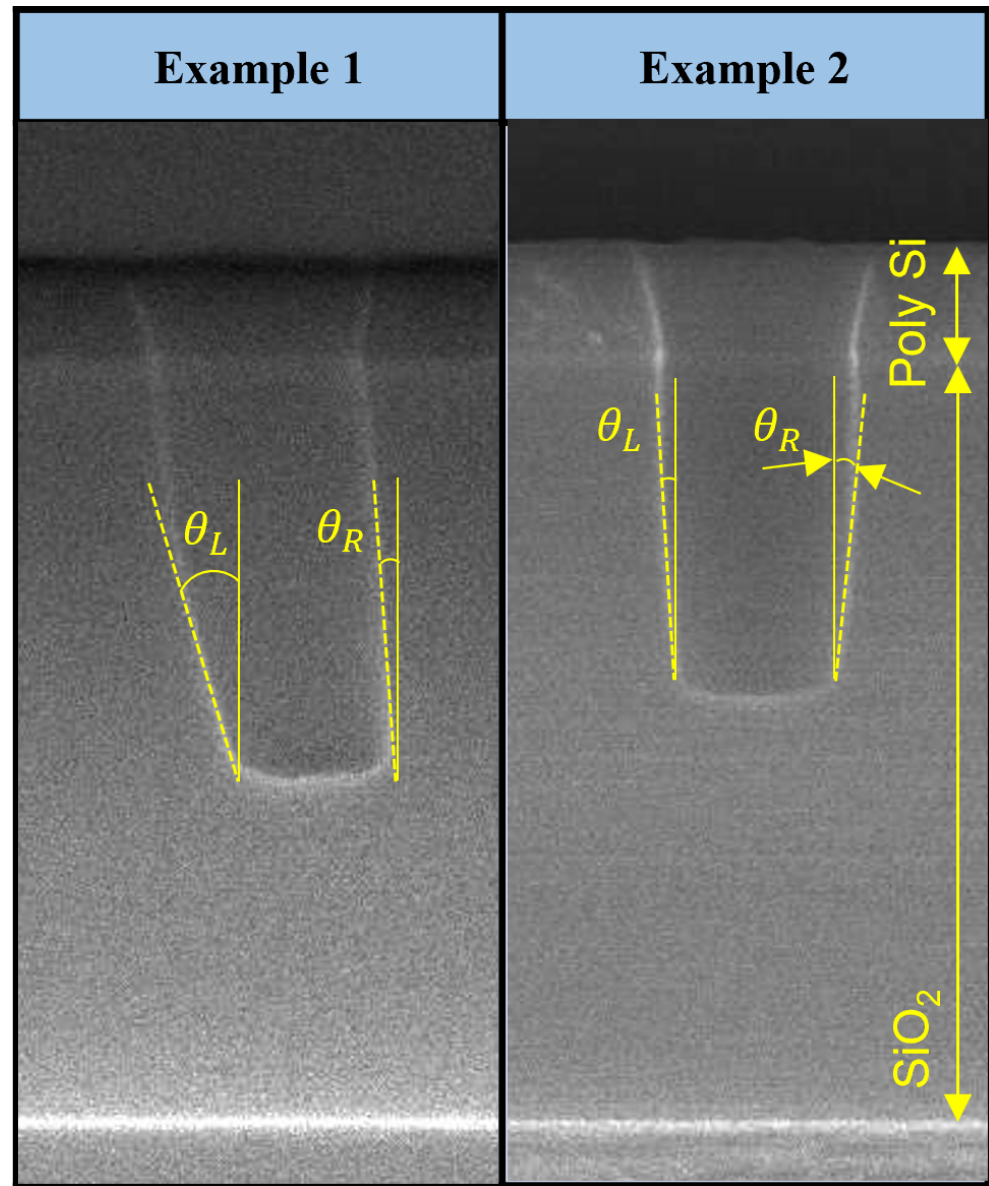
Figure 2. The definition of angles of the sidewall ( θ L and θ R